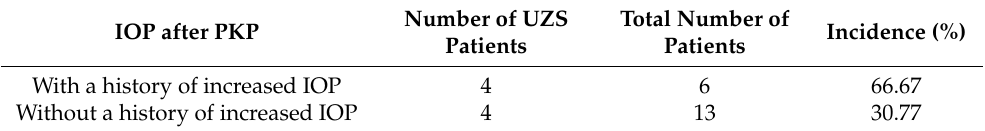
Table 3. Incidence of UZS in patients with elevated IOP after PKP.